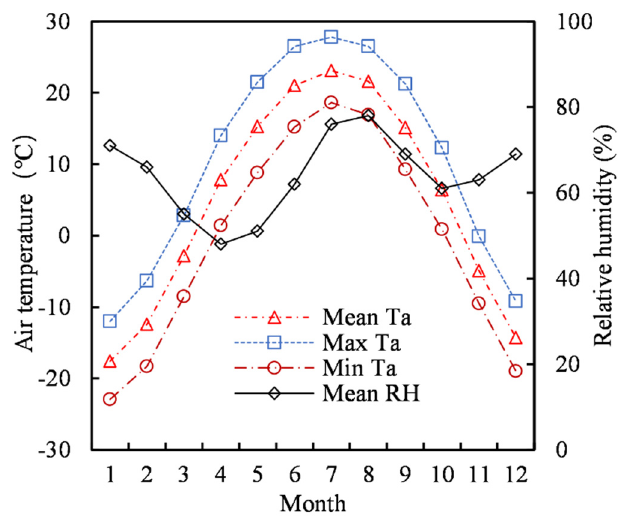
Figure 1. Monthly mean/maximum/minimum T a and mean RH in Harbin from 1981 to 2010.